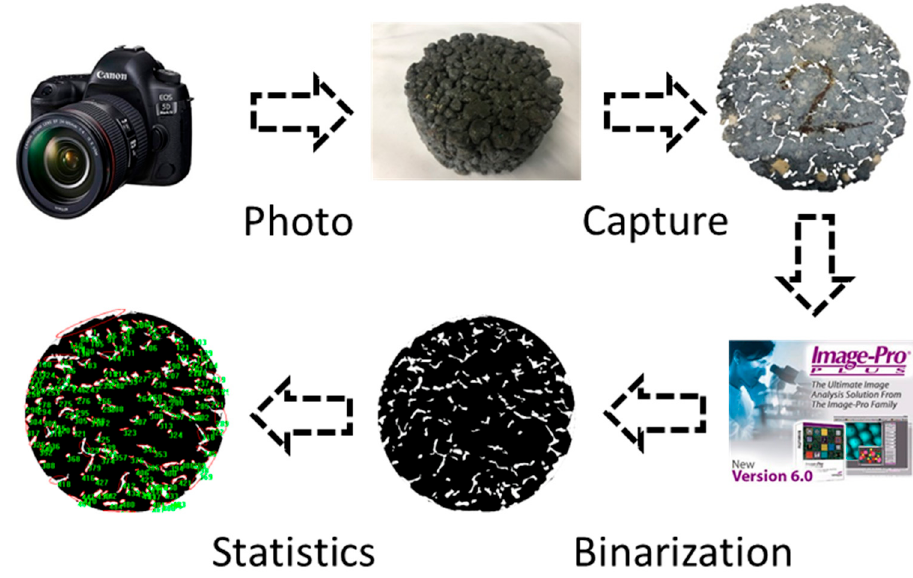
Figure 2. Schematic of the porosity determination processes of specimens using Image-Pro Plus.